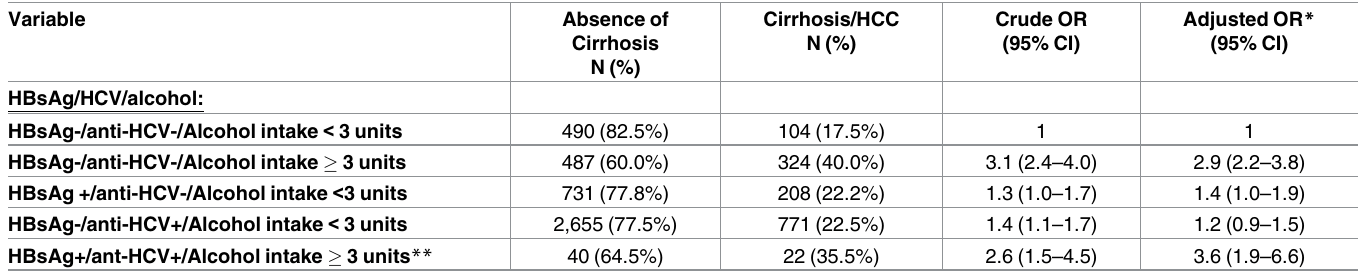
Table 3. Interaction between alcohol intake and co-factors in the progression from chronic hepatitis to cirrhosis in male patients. Crude and Adjusted * Odds Ratio derived from multiplelogistic regressionanalysis. Variable